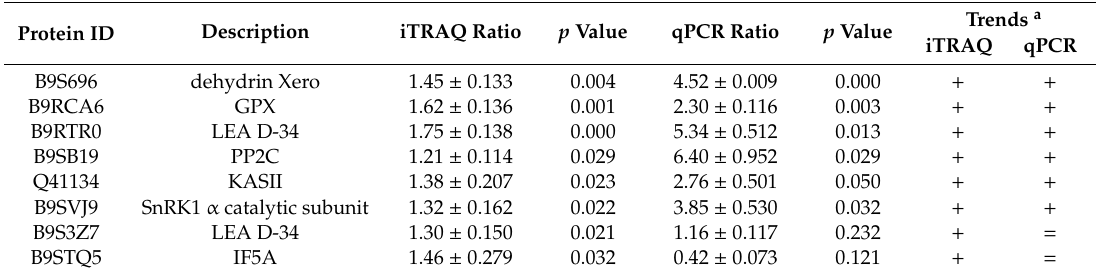
Table 2. Comparison of expression pattern at the mRNA and protein level of